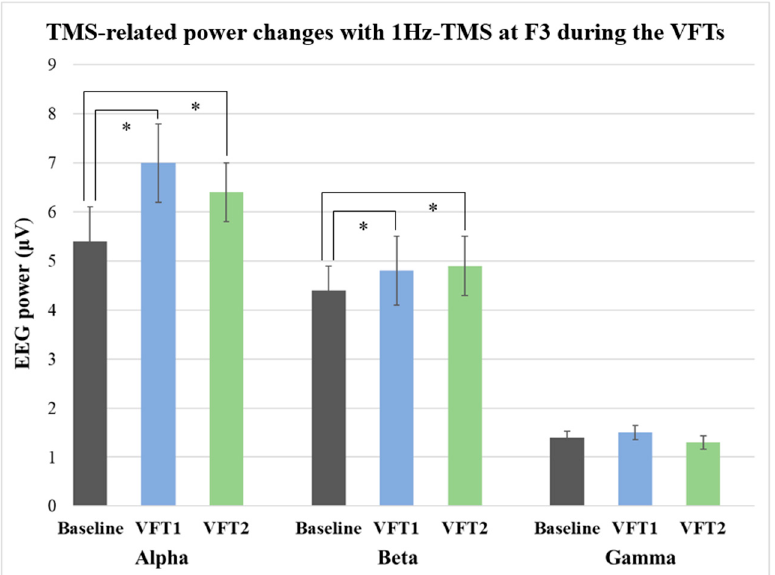
Figure 3. TMS-related power changes during the verbal fluency tasks (VFTs). One-way ANOVA with time for each band demonstrated significant power changes with 1Hz-TMS administered to the left DLPFC in alpha band during the VFT-1 (F 1,20 = 53.96, p < 0.0001) as well as during the VFT-2 (F 1,20 = 76.68, p < 0.0001). Furthermore, the ANOVA indicated significant power changes with 1Hz-TMS for the left DLPFC in beta band during the VFT-1 (F 1,20 = 20.79, p = 0.0001) as well as during the VFT-2 (F 1,20 = 13.00, p = 0.004). However, no significant changes were observed in gamma power during the VFT-1 or VFT-2. *: significant findings ( p < 0.0083).